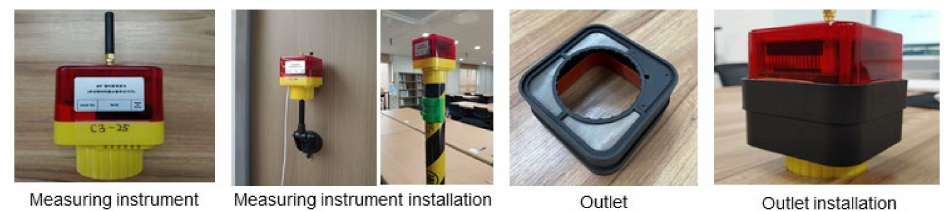
Figure 3. Measuring instrument of CPMS.